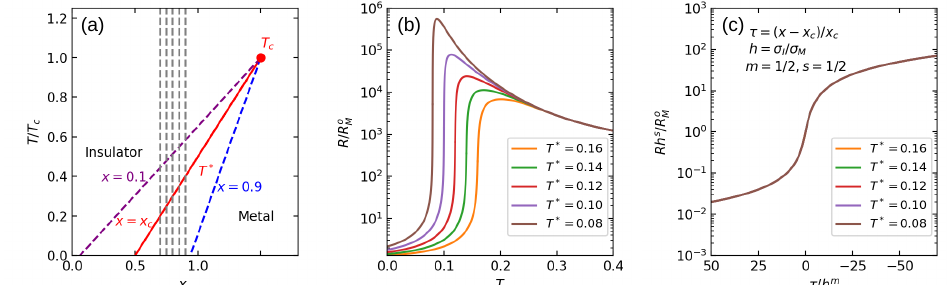
Figure 12. ( a ) The red line is x = x ( T ∗ ) . For T larger than the blue dashed line, x = 0. We calculate the percolation results along the grey dashed lines. ( b ) R / R o ( c ) Scaled resistivity curves.